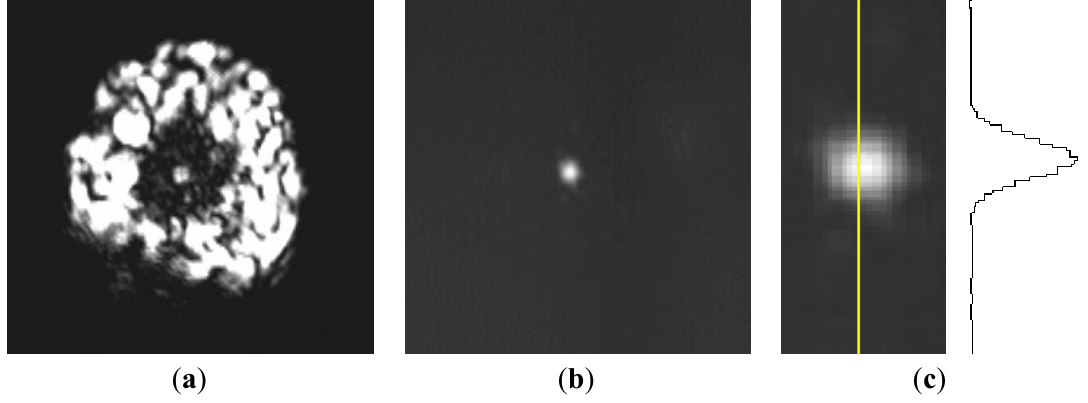
Figure 3. Near field observation at 3.39 µm of the Fiber 1: ( a ) without Ga-Sn coating; ( b ) with Ga-Sn coating in order to remove the cladding mode; and ( c ) Gaussian profile of the photonic bandgap fiber core.